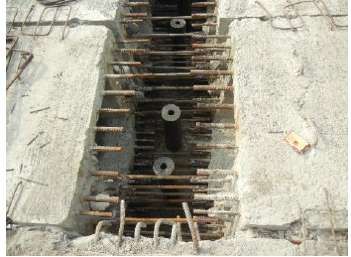
Figure 1. Semi-fixed dowel joints in the Jingpu Bridge.